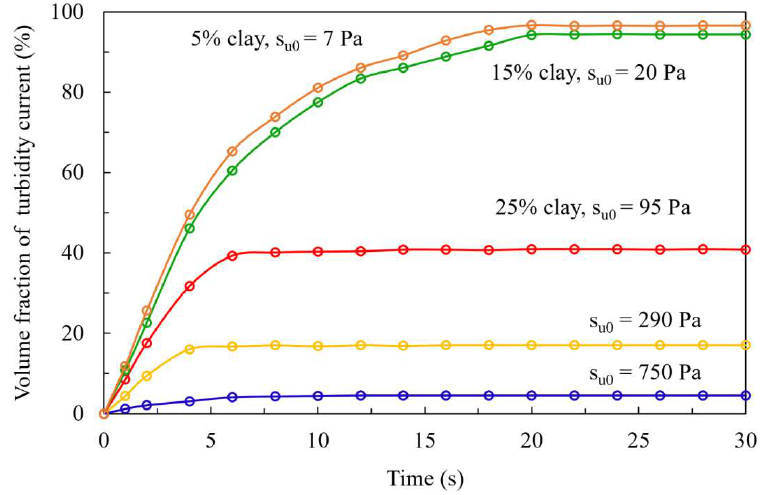
Figure 8. Change in the transformation ratio of the debris flow as a function of time.